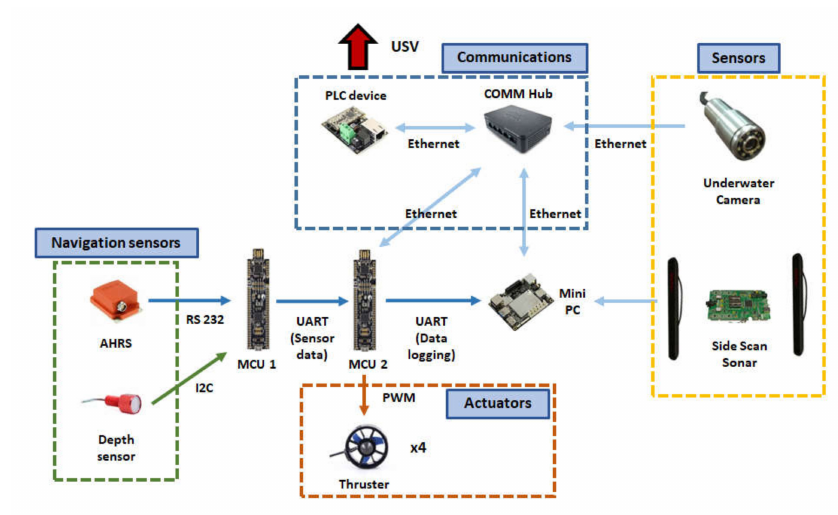
Figure 14. Diagram of UUV control system.